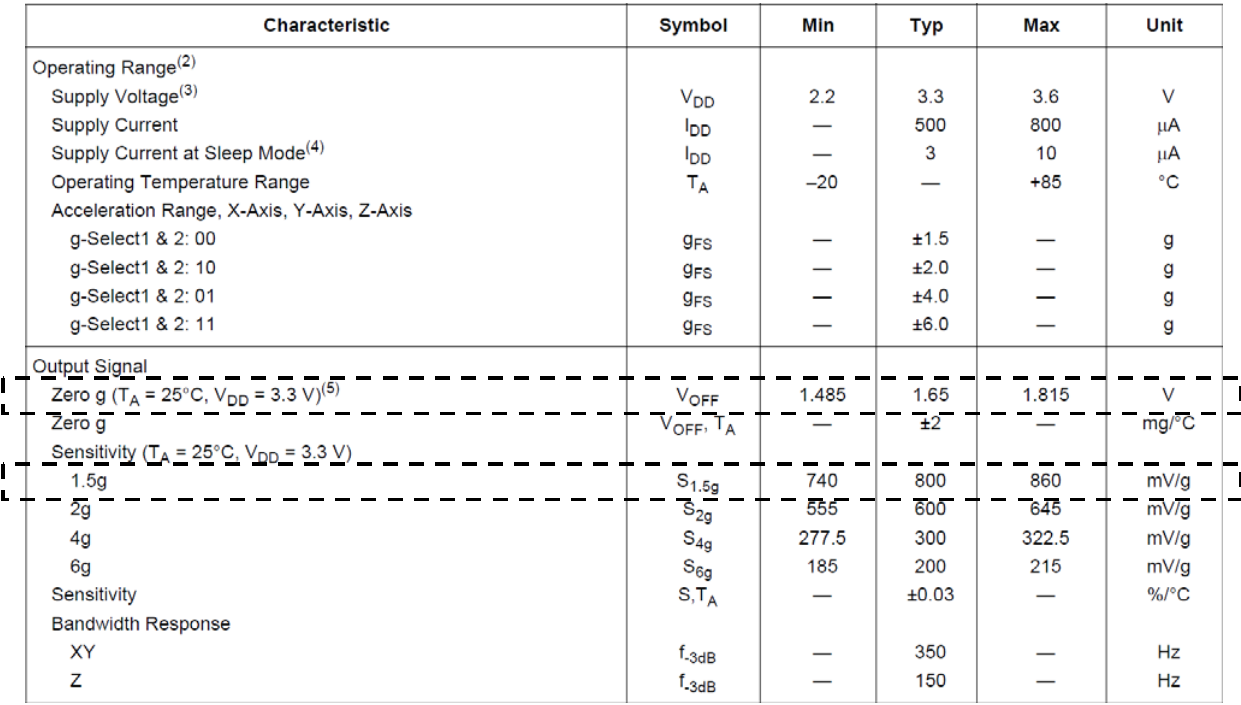
Figure 7. MMA7260Q’s Datasheet (Freescale